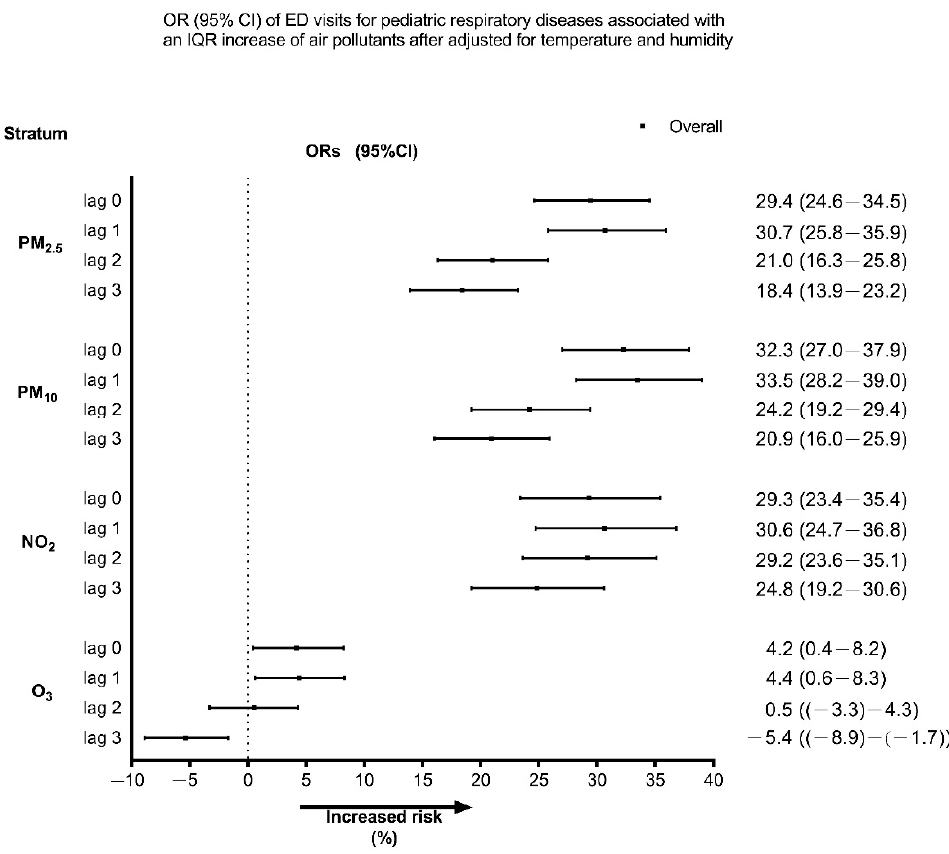
Table 4. OR (95% CI) of respiratory diseases ED visits for each interquartile range change in two- pollutant models.